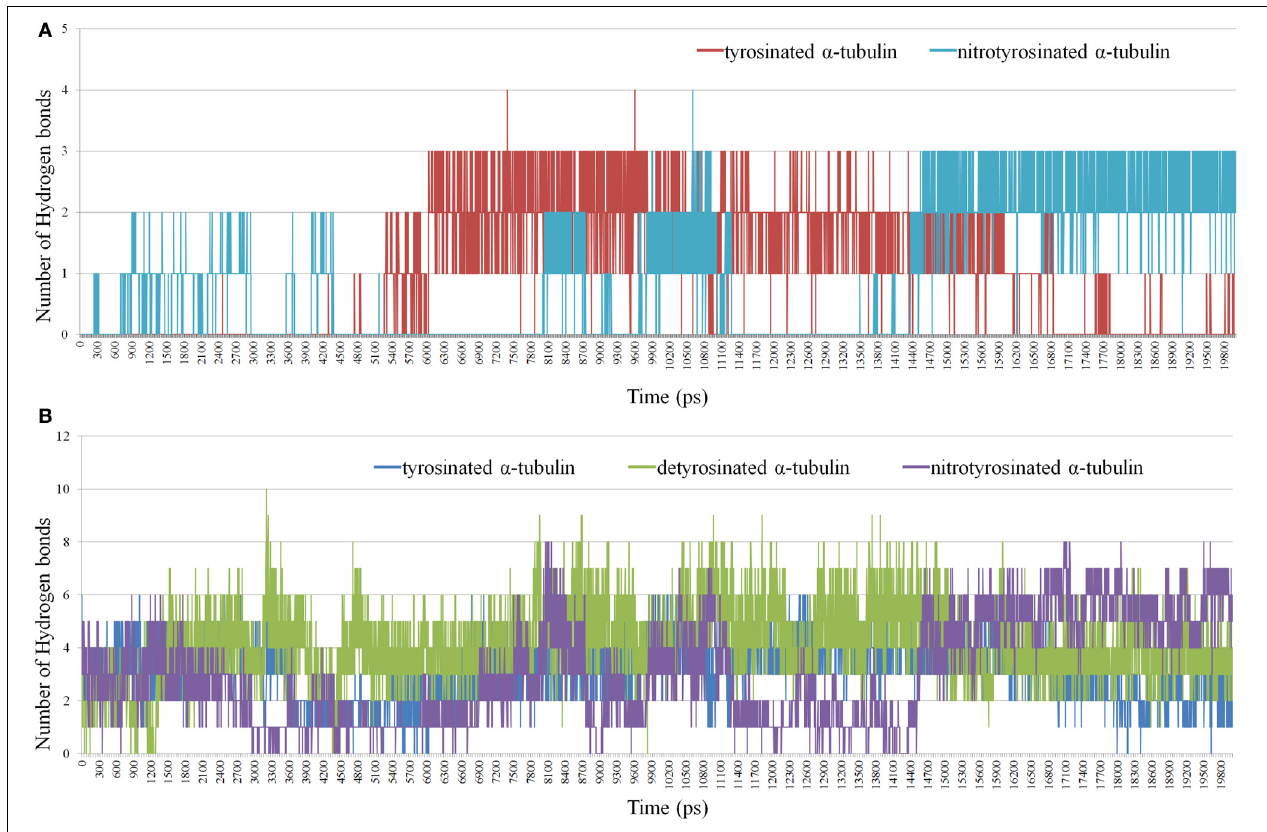
FIGURE 8 | Distribution of hydrogen bonds between kinesin-8 surface and different parts of α -tubulin. (A) Hydrogen bonds in a case of terminated non-modified and nitrated Tyr 450; (B) Hydrogen bonds in a case of the last 15 (14) residues of α